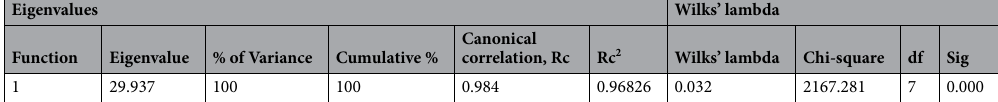
Table 6. Eigenvalues, canonical correlation and Wilk’s lambda test of discriminant function based on prostate lineage gene expressions.